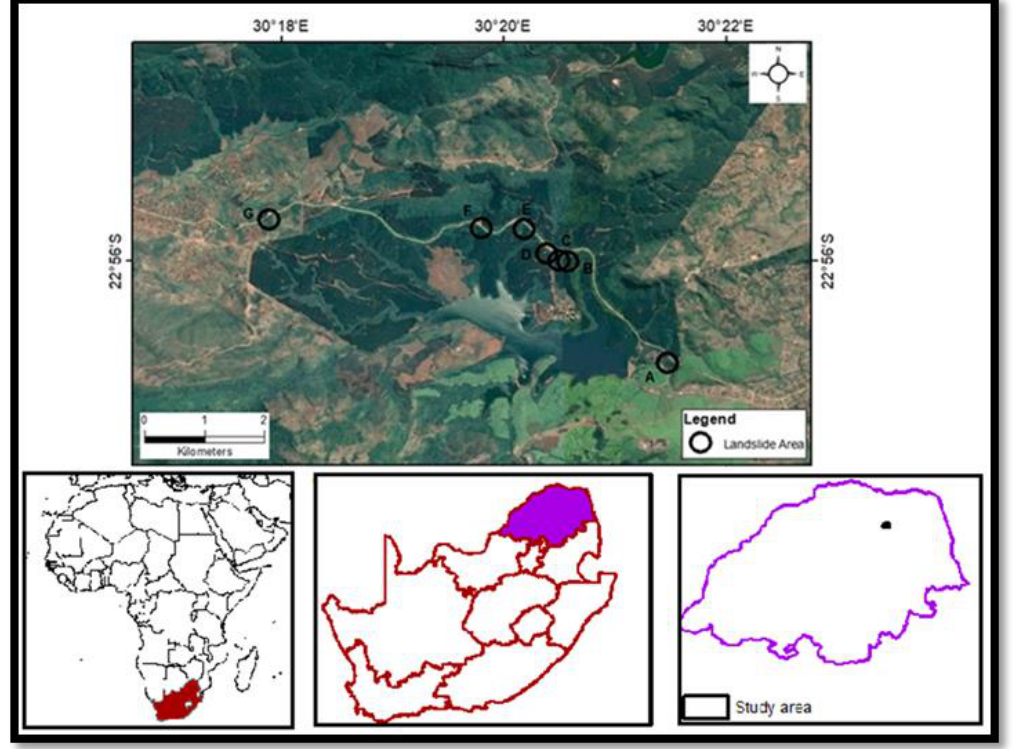
Figure 1. Locality map of the study area.